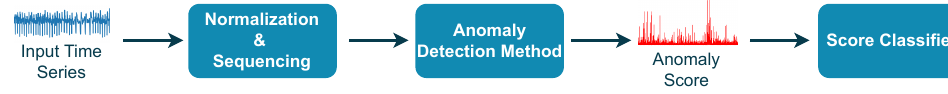
Figure 3. Benchmark pipeline used in the